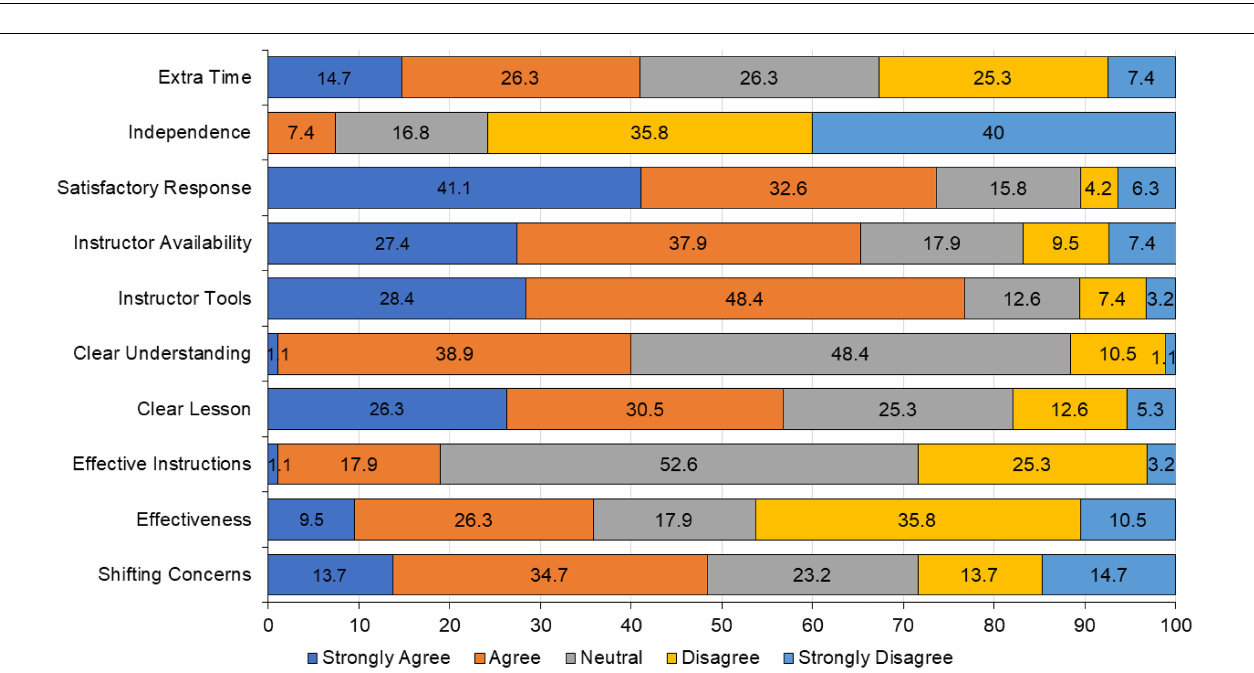
FIGURE 3 | Rating percentages of different parameters to online learning by Likert Scale.